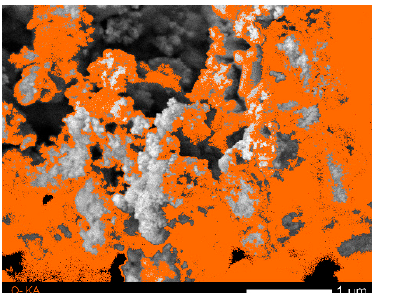
Figure 14. Mapping results for 0.7FeCeO x + 0.3 Nb 2 O 5 nanoparticles after filtration. (The color in the figure indicates the distribution of elements determined according to the mapping data: red — Fe, green — Ce, blue — Nb, orange — O, and yellow — Mn.)